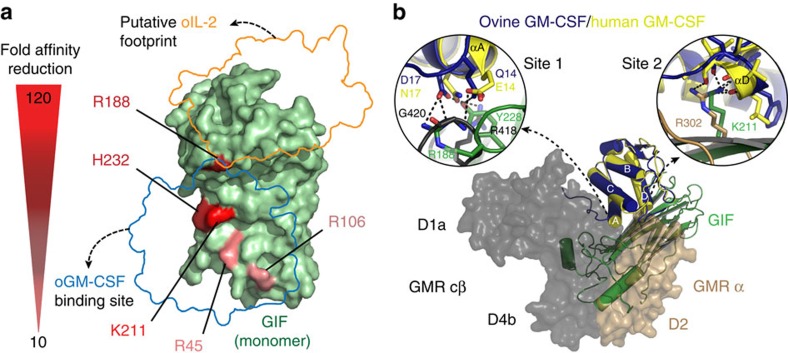
Mapping of GM-CSF and IL-2 binding footprints.(a) The GM-CSF and IL-2 interaction epitopes on GIF are mutually exclusive. Schematic overview of the effect of GM-CSF interface residue mutations on GIF. GIF is shown in dark green, and the GM-CSF and putative IL-2 binding sites are shown as outlines in blue and orange respectively. Mutated GIF residues (R45A, R106A, R188A, K211A and H232A) are coloured in different tints of red, depending on the resulting reduction in affinity for GM-CSF (120-fold affinity reduction: bright red, 10 fold affinity reduction: light pink). See also Supplementary Fig. 5 and Supplementary Table 5. (b) GIF serves as a competitive viral decoy receptor against the GM-CSF receptor. Alignment of the GIF:GM-CSF crystal structure (GIF: green, ovine GM-CSF: blue) with human GM-CSF (yellow) in the GM-CSF:GM-CSFR complex32 (PDB code: 3CXE, GMR α: brown, GMR cβ; grey). GM-CSF binding on GIF through α-helices αA and αD fully overlaps with GM-CSF binding epitopes on GM-CSFR α and cβ. Insets show a detailed zoom of binding interfaces to human and ovine GM-CSF helix αA (inset 1) and αD (inset 2). Residues on GIF or GM-CSFR involved in ovine/human GM-CSF binding are labeled and shown as sticks, polar interactions are shown as dashed lines.